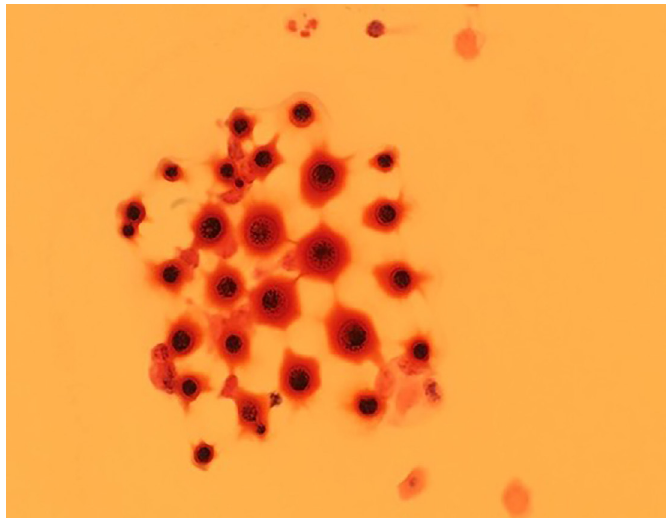
Image 2. Cerebrospinal fluid Gram stain showing variable-size yeast with narrow-based budding, characteristic of Cryptococcus gattii.